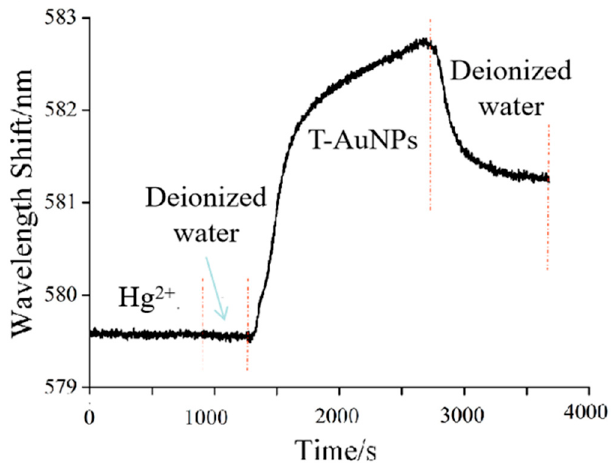
Figure 5. Sensing of Hg 2+ ions with the fiber-optic SPR sensor: real time sensing process of Hg 2+ ions.